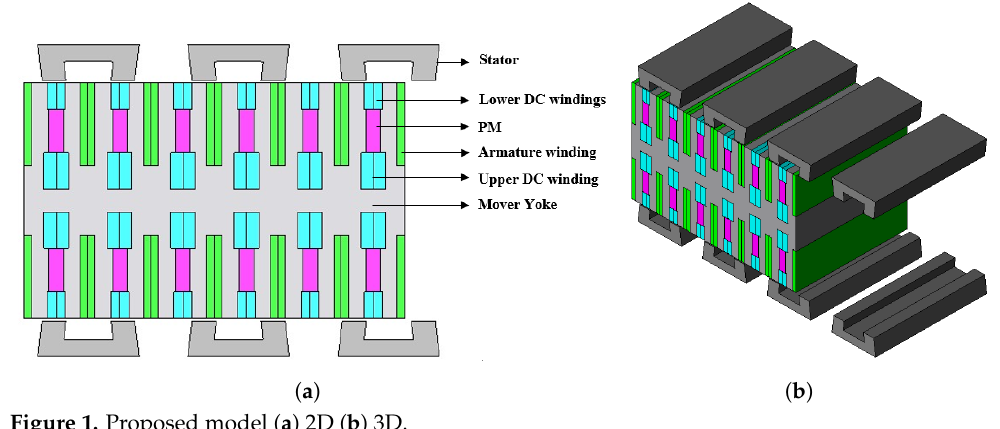
Figure 1. Proposed model ( a ) 2D ( b ) 3D.